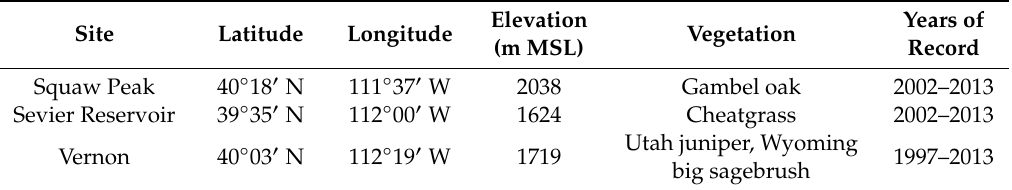
Table 1. Characteristics of live fuel moisture sampling sites in Utah near Army Garrison Camp Williams selected for analysis and available years of data.